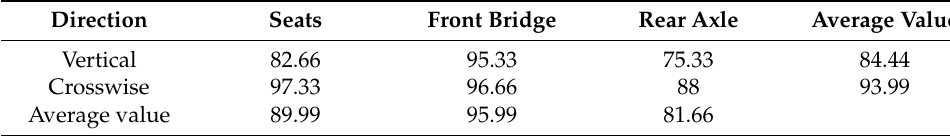
Table 5. Recognition accuracy of SVM (%).